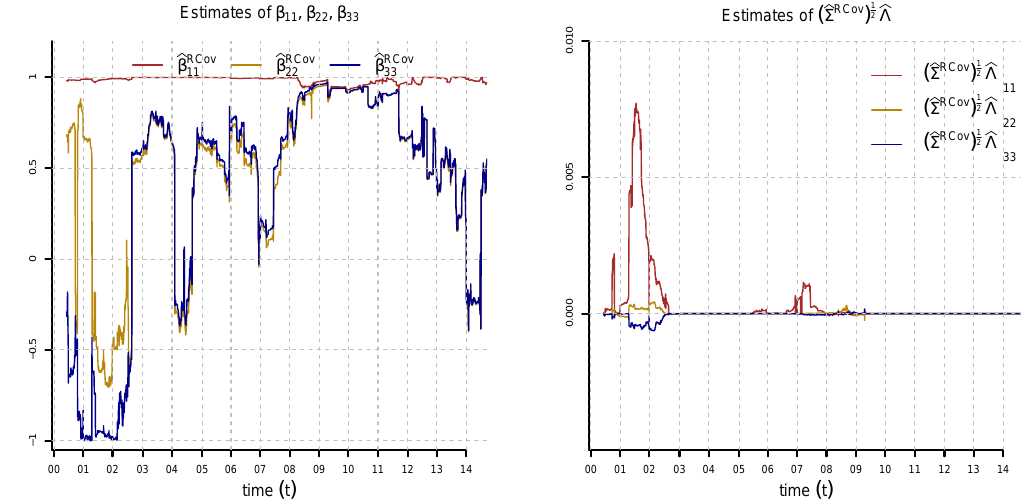
Figure 11. Estimation of β 11 , β 22 and β 33 (lhs) and ( Σ 1 2 Λ ) 11 = β 11 − α 11 , ( Σ 1 2 Λ ) 22 = β 22 − α 22 and = β − α ( Σ 1 2 Λ ) 33 33 33 (rhs) by optimizations (23) and (24) in the three-factor model for K M = 6, τ 1 = 1, τ 2 = 2, τ 3 = 5, τ 4 = 10, τ 5 = 21, τ 6 = 63, w ij = 1 { i = j } and S = 10 − 5 · 1 . The values determine the speed of mean reversion of the factors. Since we are considering a daily time grid, values close to one (slow mean reversion) are reasonable. We observe that the difference in the speed of mean-reversion under the risk-neutral and real-world measures is negligible.